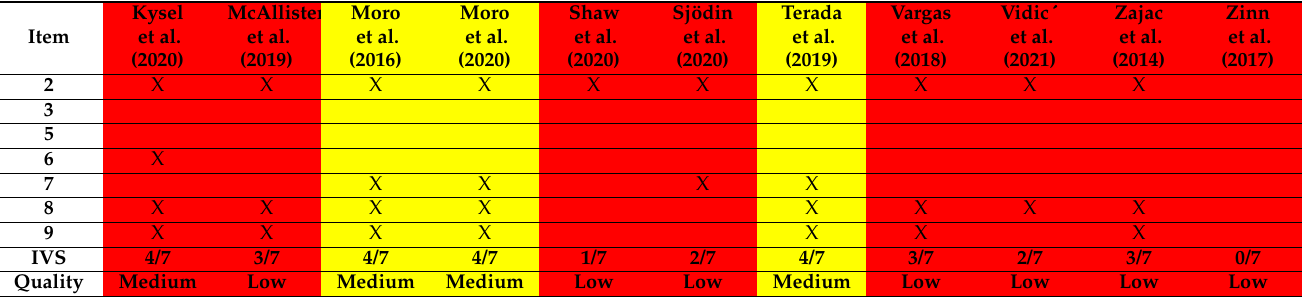
Table 4. Assessment of internal quality using IVS scale. Articles 11 to 21.